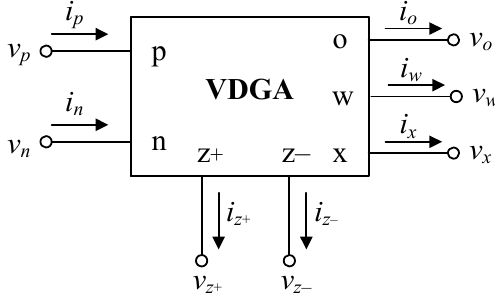
Figure 1. Schematic representation of the VDGA.